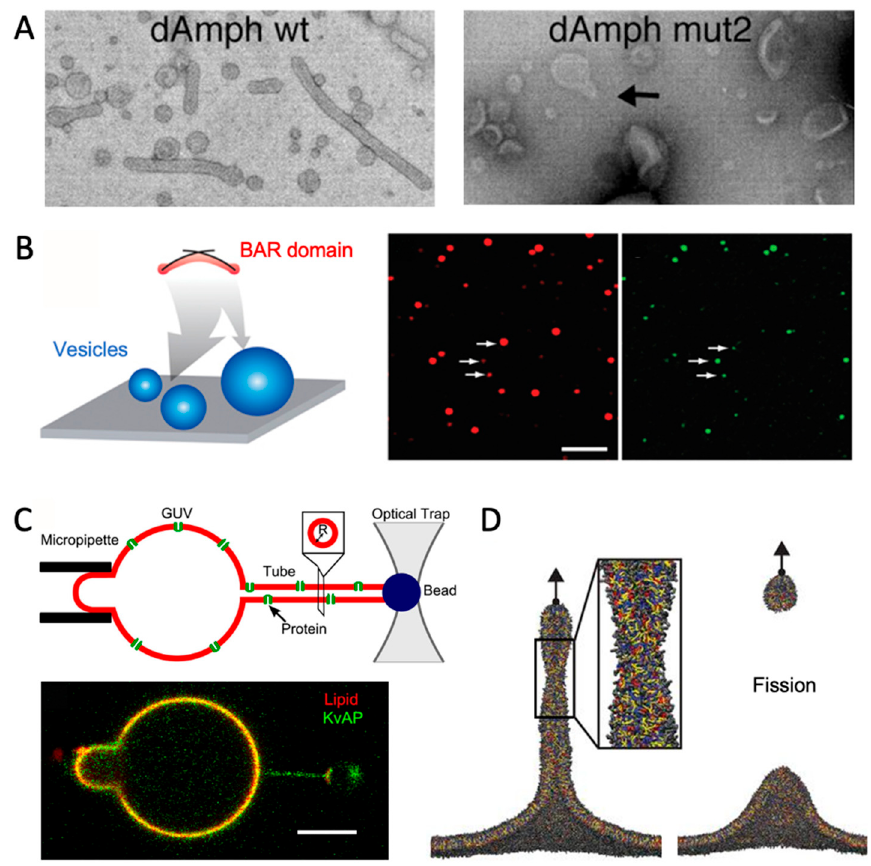
Figure 5. Experiments for measuring membrane curvature. ( A ) Electron microscopy images of how amphyphysin (wild type and mutant “mut2”) induce transitions from vesicles towards tubules. Adapted with permission from Ref. [75] (copyright 2004, The American Association for the Ad- vancement of Science). ( B ) Fluorescent liposomes (red, middle panel) on a surface with bound BAR domains (green, right panel). Adapted with permission from Ref. [78] (copyright 2009, John Wiley and Sons). ( C ) Tethering from GUV with optical tweezer, adapted with permission from Ref. [79] (copyright 2014, Elsevier). ( D ) Simulated tethering and fission event, adapted with permission from Ref. [60] (copyright 2014, The American Association for the Advancement of Science).